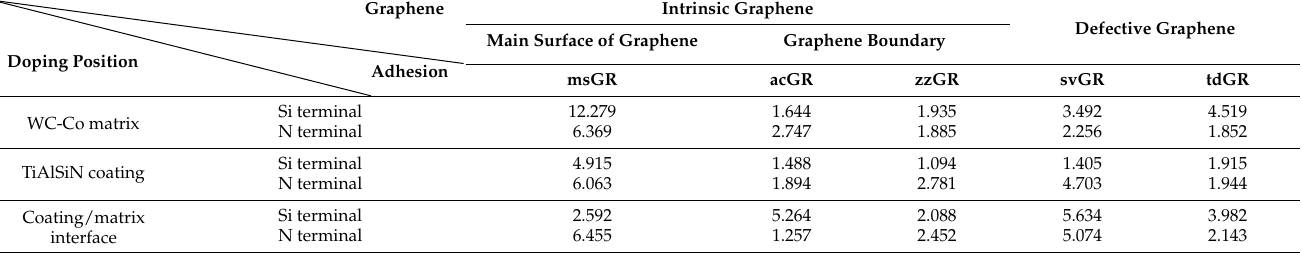
Table 8. Adhesion works of TiAlSiN/WC-Co interface doped with graphene.